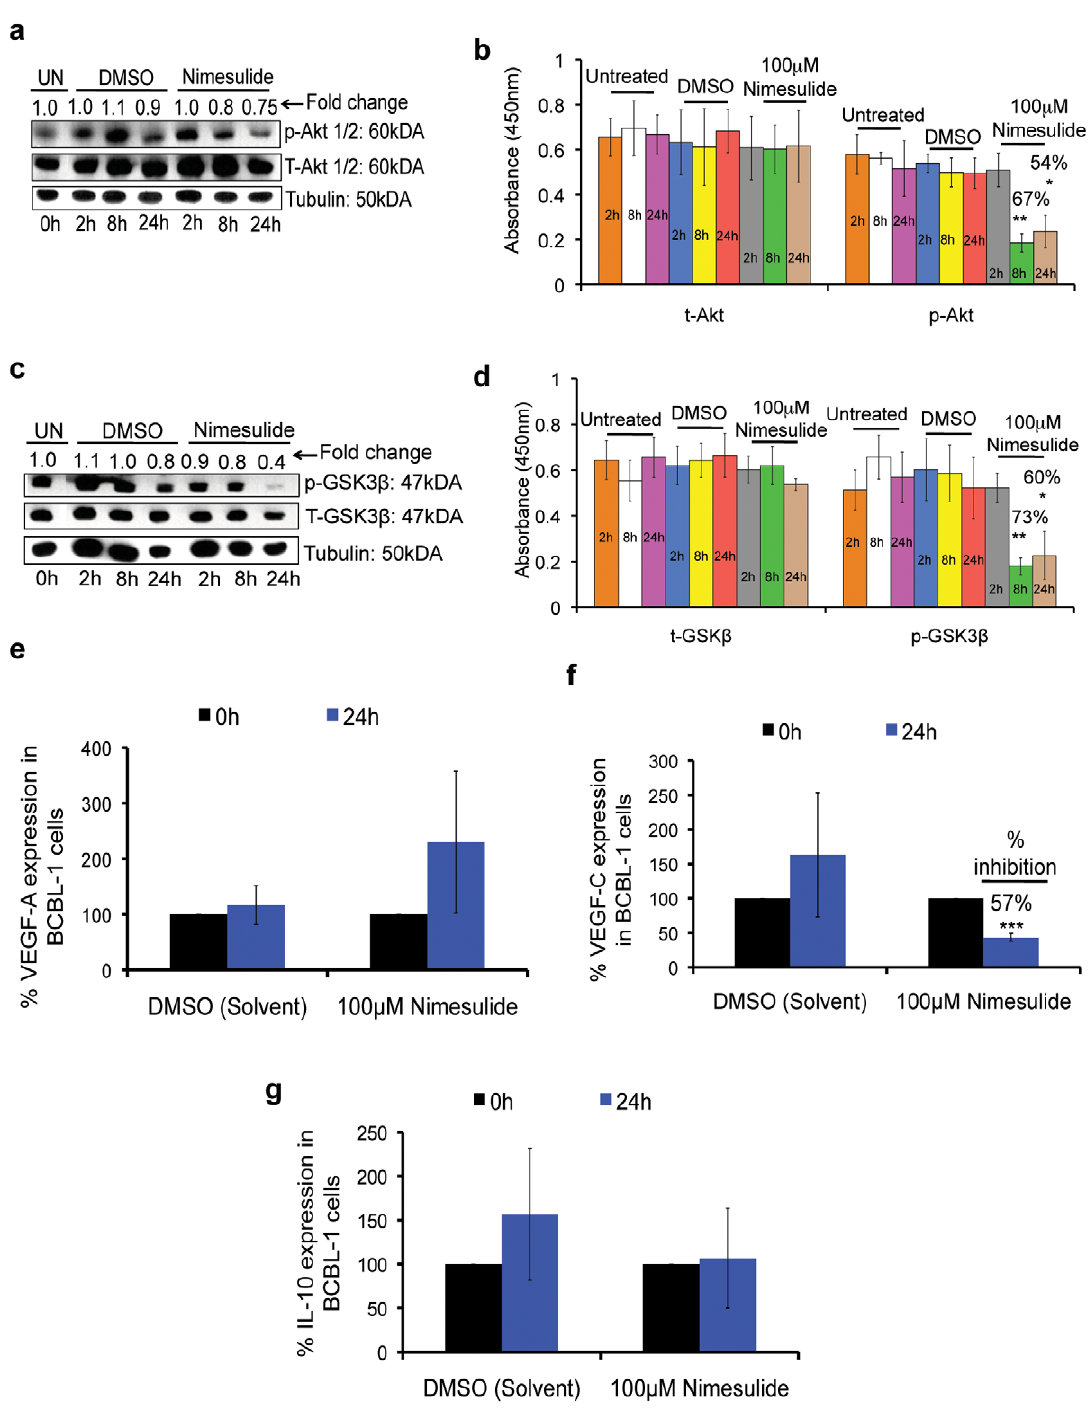
Figure 7. Effect of nimesulide on p-Akt, p-GSK-3 b , IL-10, VEGF-A, and VEGF-C. ( a and c ) 5 6 10 5 BCBL-1 cells were seeded with 100 m M nimesulide or DMSO and total lysates were collected at 2 h, 8 h, and 24 h post-treatment and immunoblotted for p-Akt 1/2 ( a ) and p-GSK-3 b ( c ) and normalized with respect to t-Akt 1/2 and t-GSK-3 b , respectively. Tubulin was used as the loading control for each blot. The cells were neither replenished with fresh media nor supplemented with the drugs. The fold change was calculated with respect to untreated (UN) cells at 0 h. The data is representative of duplicate experiments. ( b and d ) 5 6 10 5 BCBL-1 cells were seeded with 100 m M nimesulide, DMSO or left untreated and samples were collected at 2 h, 8 h, and 24 h post-treatment to measure t-Akt ( b ), p-Akt ( b ), p-GSK-3 b ( d ), and t-GSK-3 b ( d ) by FACE assay. The cells were neither replenished with fresh media nor supplemented with the drugs. ( e–f ) 5 6 10 5 BCBL-1 cells were seeded with 100 m M nimesulide or DMSO or left untreated (UN) without replenishment with fresh media. RNA was isolated at 24 h post-treatment with the drug to examine the gene expression levels of VEGF-A ( e ), VEGF-C ( f ), and IL-10 ( g ) by real-time RT-PCR. The cells were neither replenished with fresh media nor supplemented with the drugs. The fold change and corresponding statistics (t-test) were calculated with respect to untreated (UN) cells for each treatment. (***) p , 0.0005. ( b, d, e, f, g ) Each experiment was done in tripicate, and each point represents the average 6 S.D. from three independent experiments.